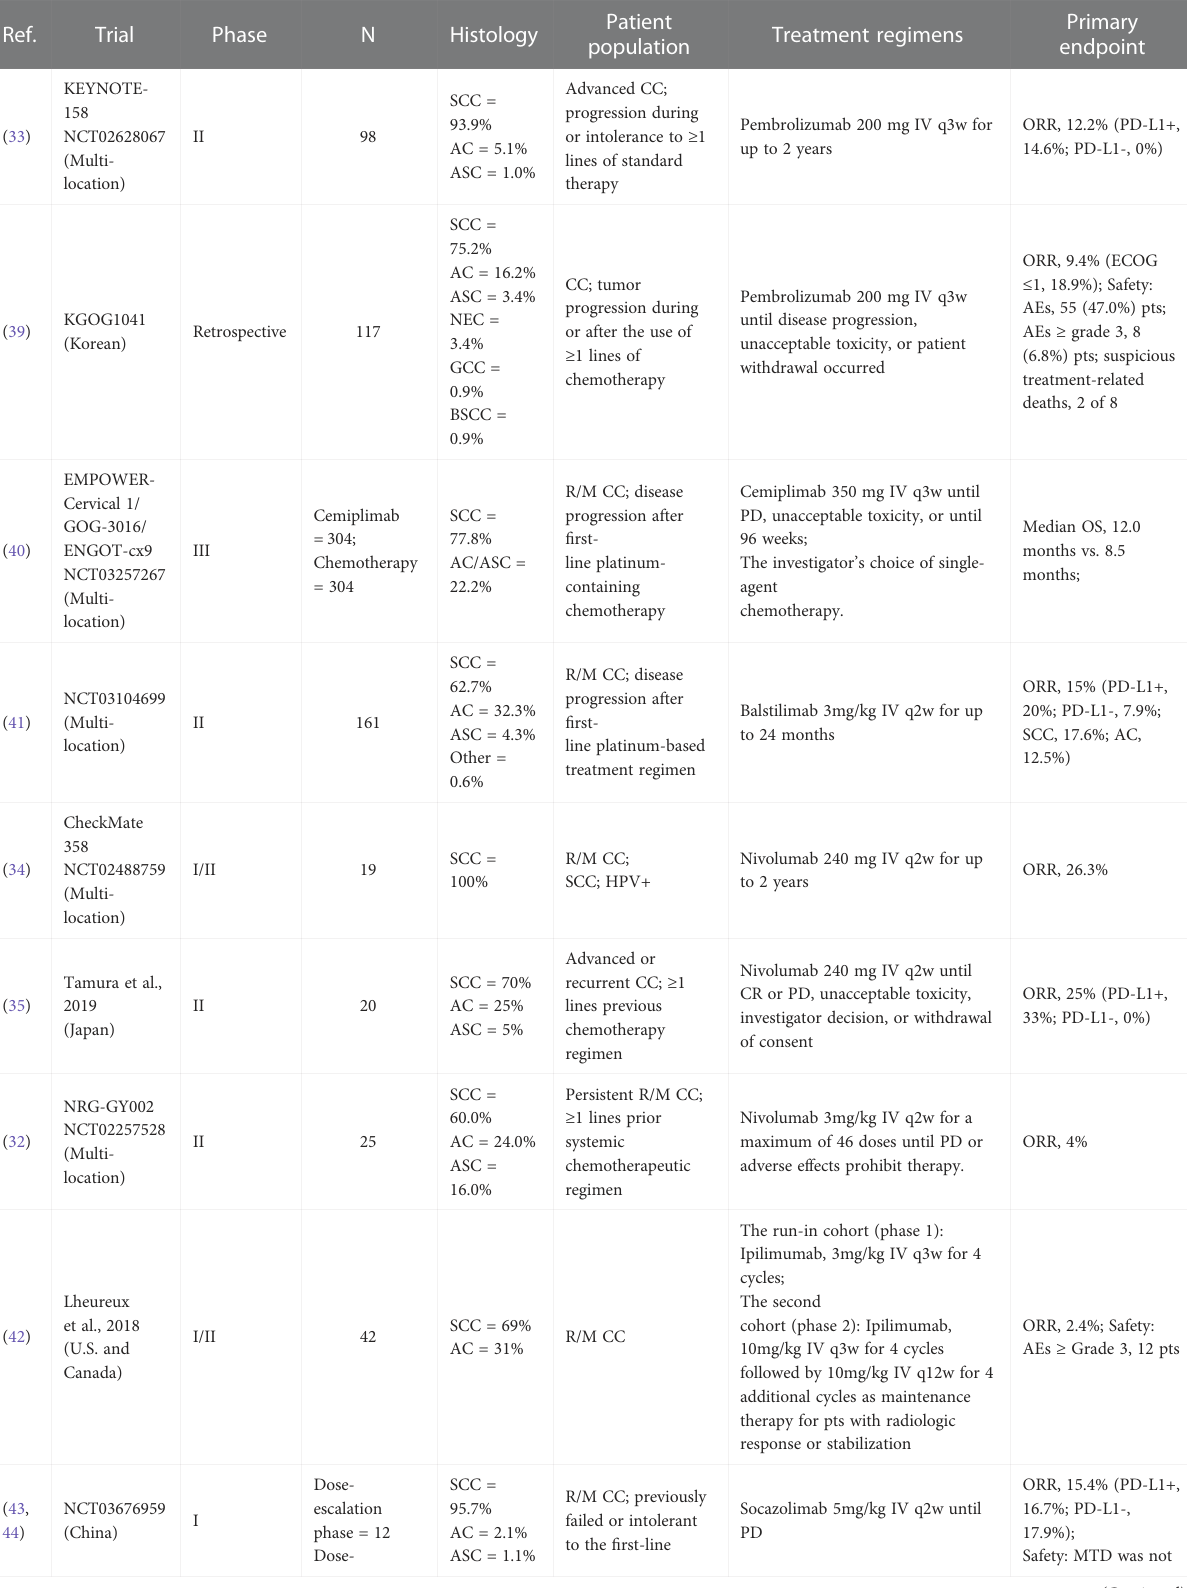
TABLE 2 Published data on immune checkpoint drug monotherapy for recurrent/metastatic cervical cancer.